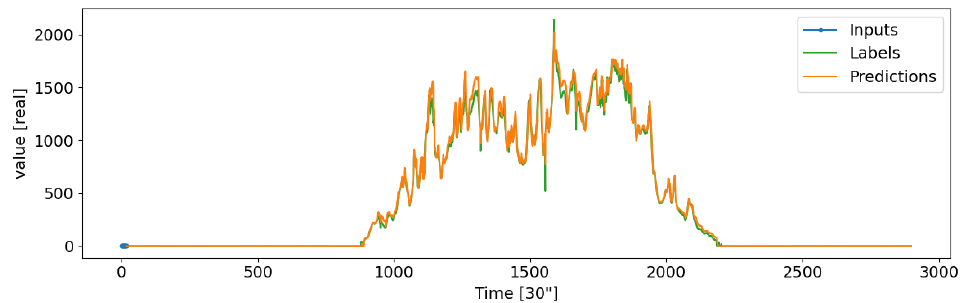
Figure 8. An example of performance of the WaveNet (20, 1, 1) architecture on a test data window. These data represent solar irradiance of a single day predicted by iteratively taking into consideration rolling input data and using output to predict a single future